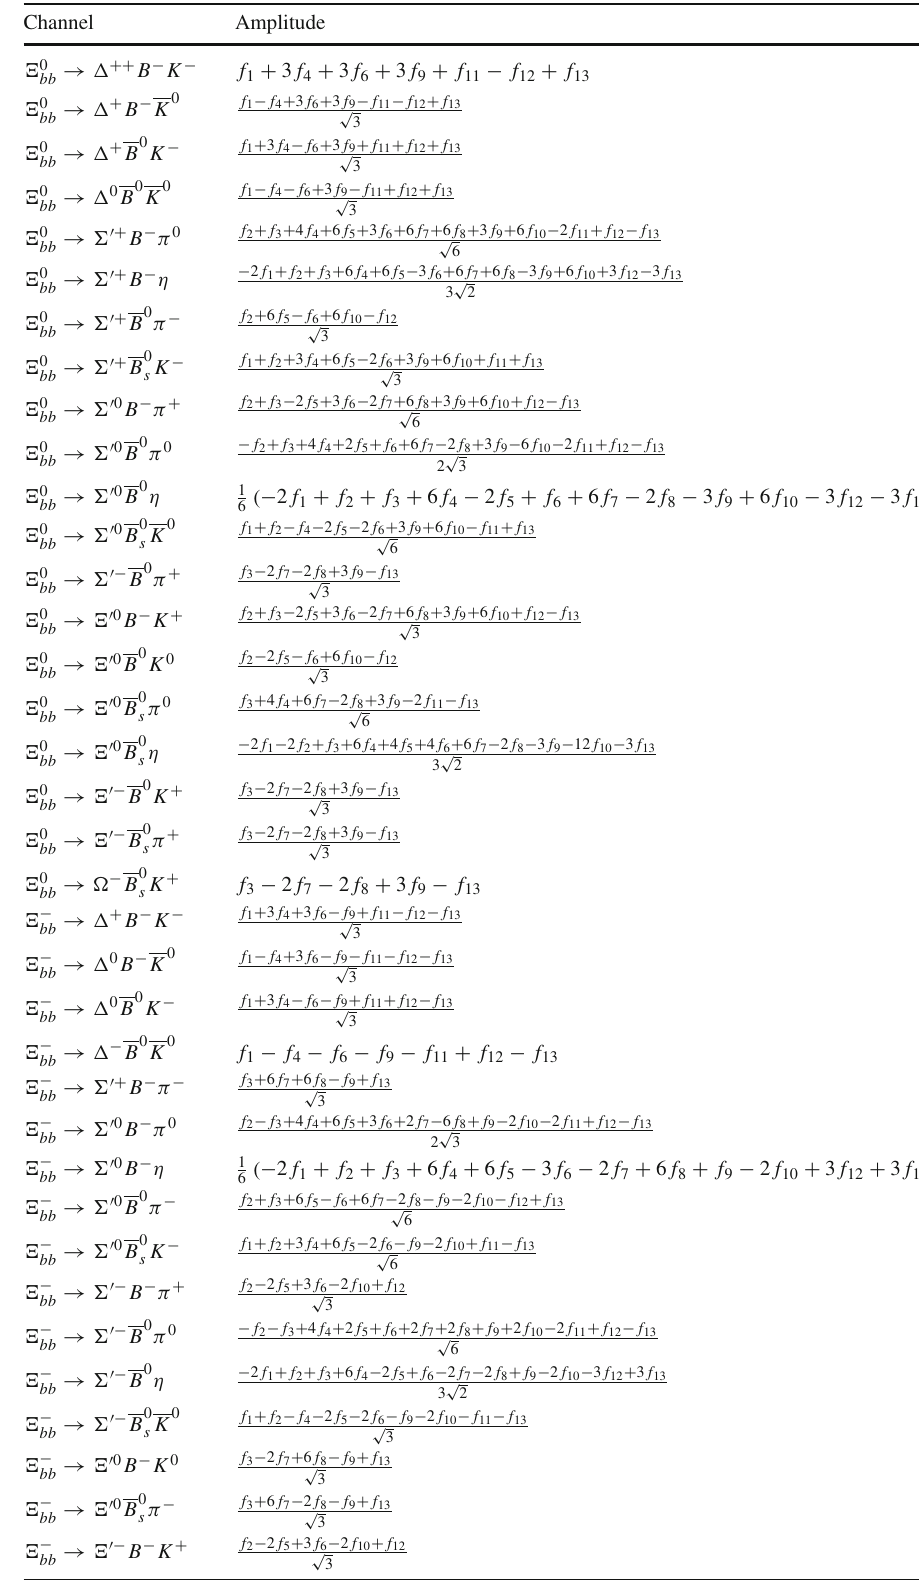
Table 34 Doubly bottom baryon decays into a bottom meson, a light baryon(10) induced by the charmless b → s transition and a light